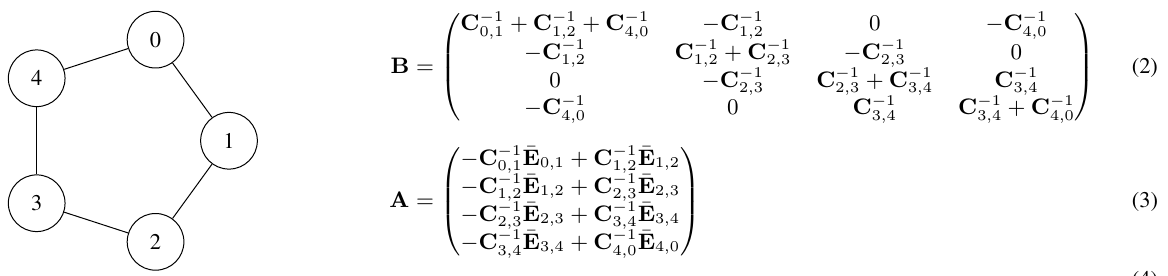
Figure 1. Simple loop containing 5 vertices. The corresponding system of linear equations is shown on right side.